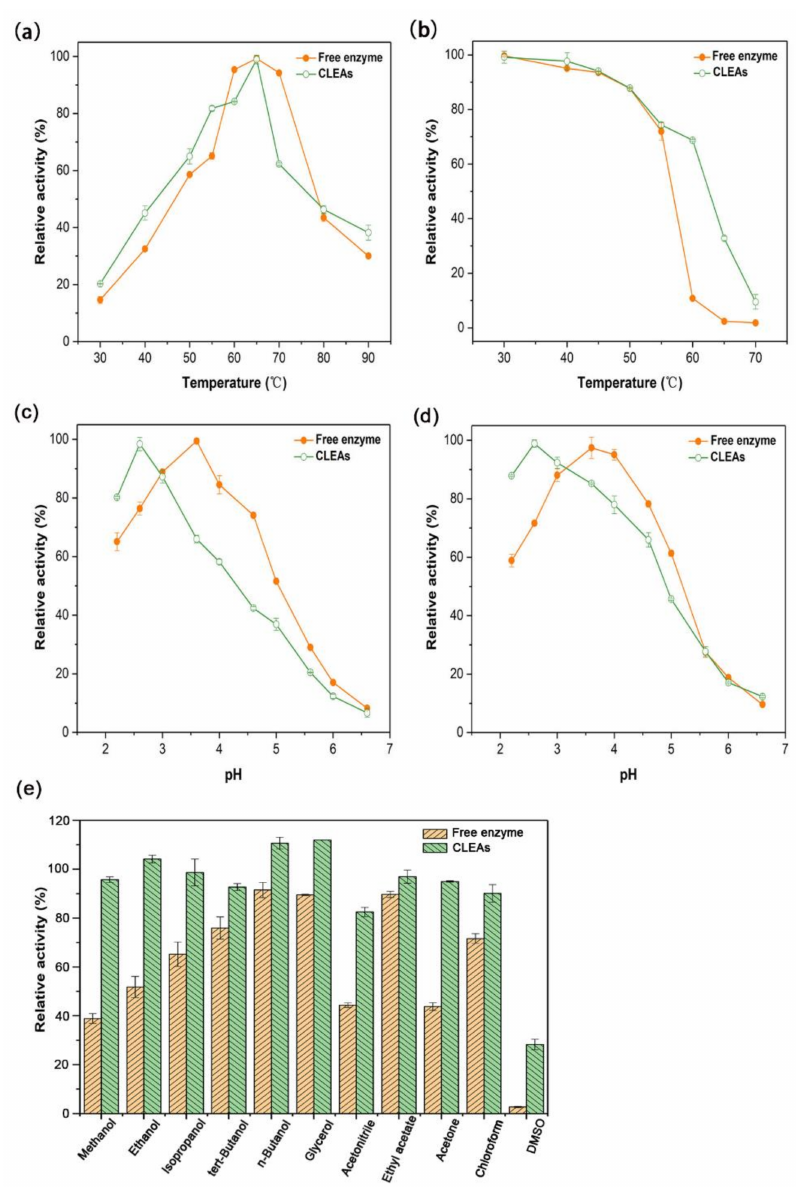
Figure 4. The effects of temperature, pH, and organic solvents on activities and/or stabilities of the free enzyme and Aga-CLEAs. ( a , b ) the effects of temperature on the activity and stability, respectively; ( c , d ) the effects of pH on the activity and stability, respectively; ( e ) the stability of the free enzyme and CLEAs in the presence of different organic solvents at 10% ( v/v ) concentration. Data points are the average of triplicate measurements, and error bars represent standard